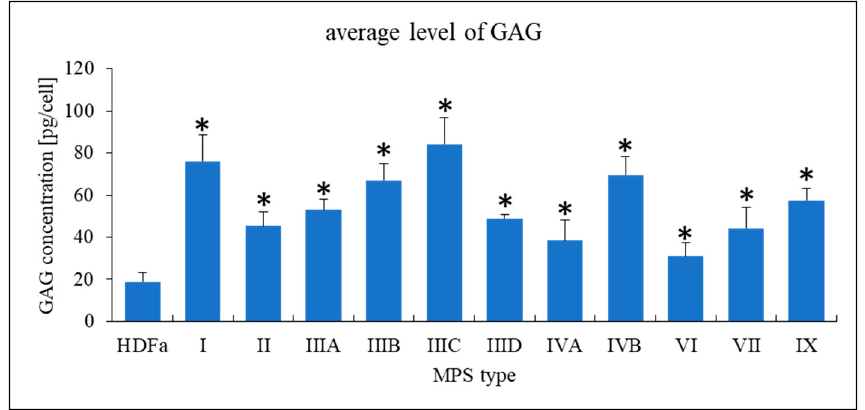
Figure 1. Levels of GAGs in tested lines of MPS fibroblasts relative to the control cell line (HDFa). The presented values are mean values from three independent experiments with error bars representing SD. Statistically significant differences (*; p < 0.05) were found for each MPS type relative to HDFa. Using transcriptomic data, we analyzed levels of transcripts of genes grouped into Table 1. Number of up- and downregulated transcripts (at FDR < 0.1; p < 0.1) of genes included into GO terms ‘Cellular component organization’ (GO:0016043) and ‘Cellular anatomical entity’ (GO:0110165) in different types of MPS relative to control cells (HDFa).